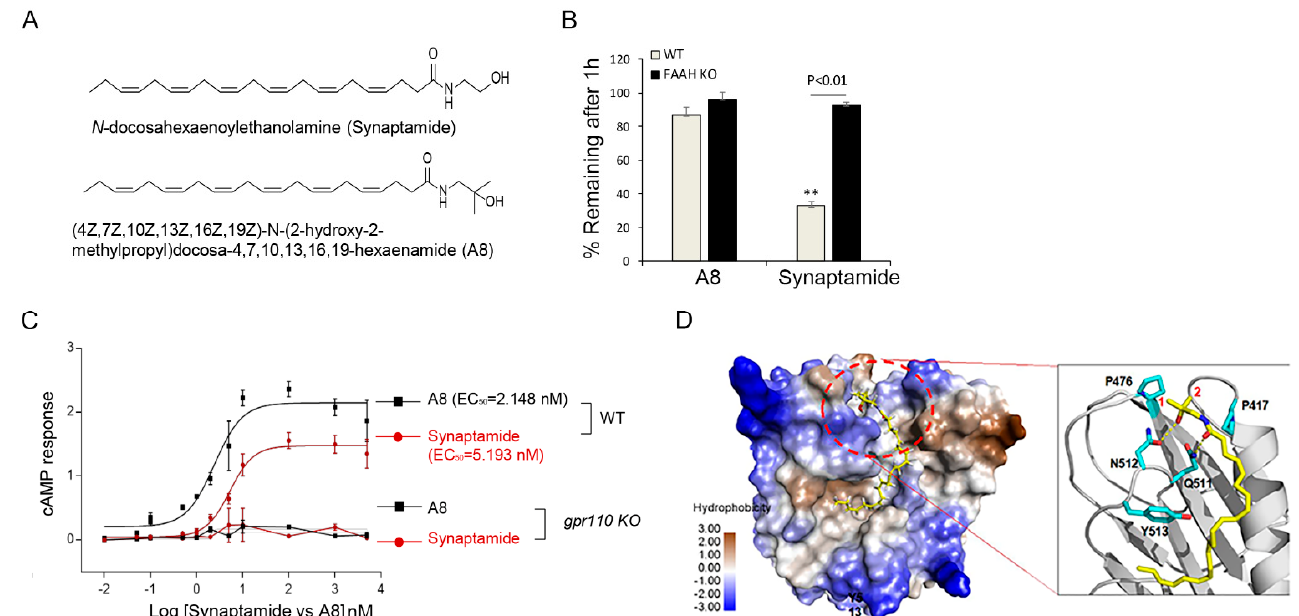
Figure 6. A8, a FAAH-resistant structural analogue of synaptamide, exhibited improved cAMP production and receptor binding. ( A ) Chemical structures of synaptamide and its stable analogue A8 ((4Z,7Z,10Z,13Z,16Z,19Z)-N-(2-hydroxy-2-methylpropyl)docosa-4,7,10,13,16,19-hexaenamide). ( B ) Synaptamide and A8 remaining after incubation with brain homogenates from WT or fatty acid amide hydrolase (FAAH) KO mice for 1 h, showing that A8 is resistant to FAAH hydrolysis. ( C ) Dose-dependent increase in cAMP production elicited by synaptamide and A8. Cortical neurons derived from P0 brains were stimulated for 15 min on DIV3 for cAMP measurement. ( D ) Improved binding ability of A8 to GPR110 predicted by the binding model of A8 at the GAIN domain of GPR110. The protein surface is rendered in the color of hydrophobicity. A8 is shown in sticks of yellow carbon atoms, and key residues at the hydrophobic pocket are shown in sticks of cyan carbon atoms. O and N atoms are shown in red and blue, respectively. The two methyl groups (labeled with 1 and 2) of A8 fit well in the hydrophobic pocket formed by P470 and P417. The resulting hydrophobic interaction stabilizes the hydrogen bonding between the polar moieties of GPR110 and synaptamide or A8 (dotted yellow lines). ** p < 0.01 vs. A8.